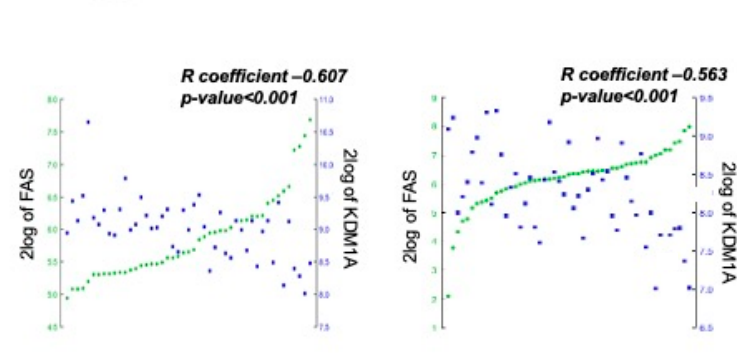
Figure 2. Inhibiting KDM1A strongly enhanced FAS on neuroblastoma cell surface. ( A ) Illustration of FAS regulation in tumor cells. ( B ) Pearson correlations between FAS and KDM1A expression on the left side across 47 samples [22] and on the right side across 51 samples from primary neuroblastomas [23] (source: R2: Genomics Analysis and Visualization Platform (http://r2.amc.nl, accessed on 27 September 2021)). ( C ) Flow cytometrically determined FAS surface expression in neuroblastoma cell lines after 72 h of treatment with 0.5 µM KDM1A inhibitor (SP-2509), irradiation with 2 Gy, or a combination of both (mean ± SD, n = 3). ( D ) L1CAM, TP53 and FAS protein expression in neuroblastoma cells after 72 h